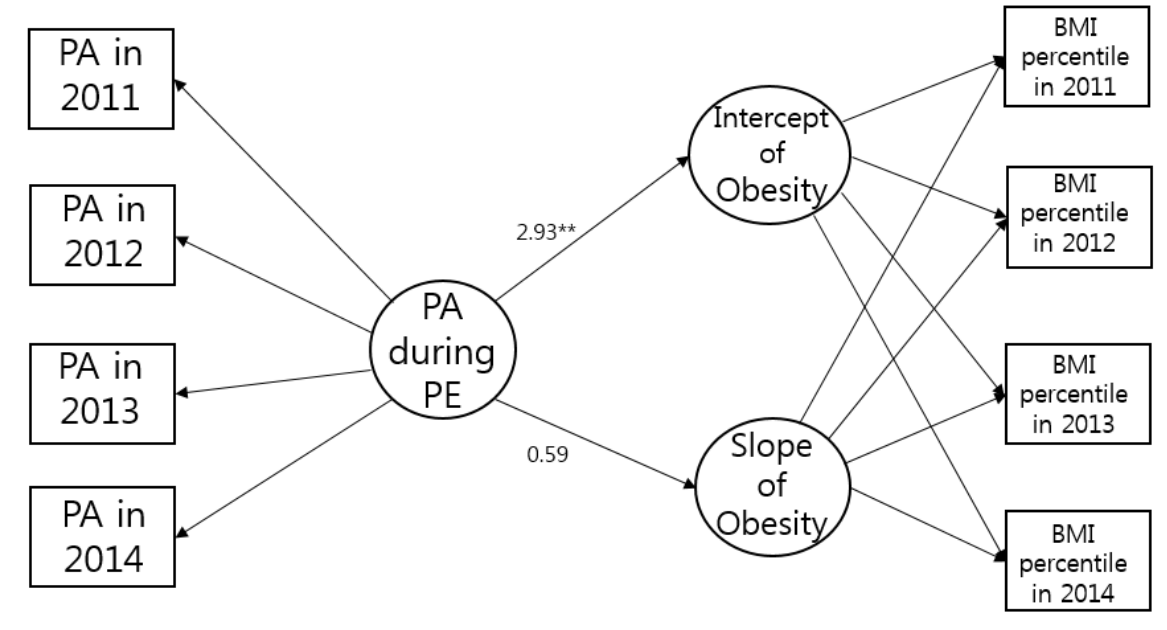
Figure 1. Final model of obesity status. ** p <